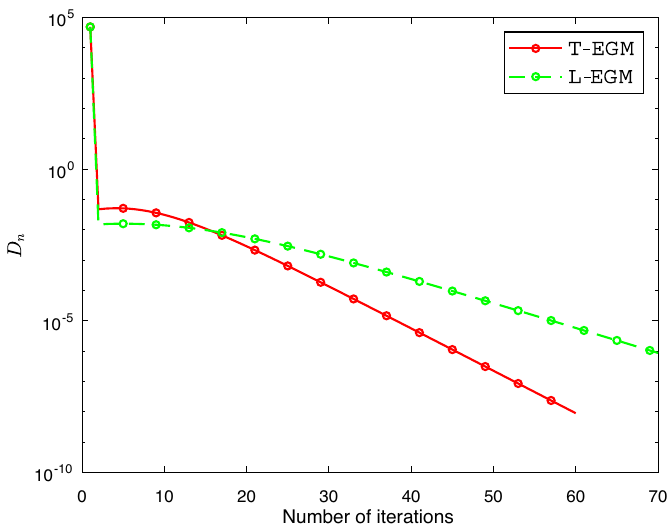
Figure 5: Numerical illustration of Algorithm 1 in [ 28 ] and Algorithm 1 in [ 29 ] while u